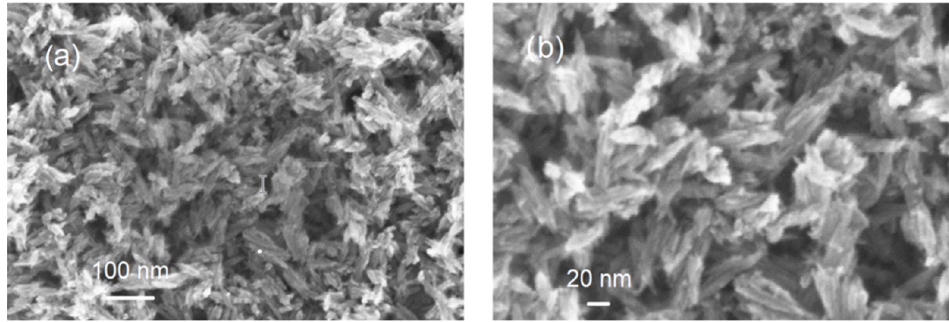
2 powder; ( b ) TEM image of nano-TiO 2 .